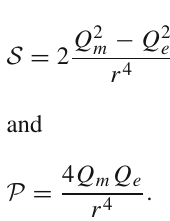
(cid:5) √ (cid:6) 2 with equal steps (from bottom to top) 2